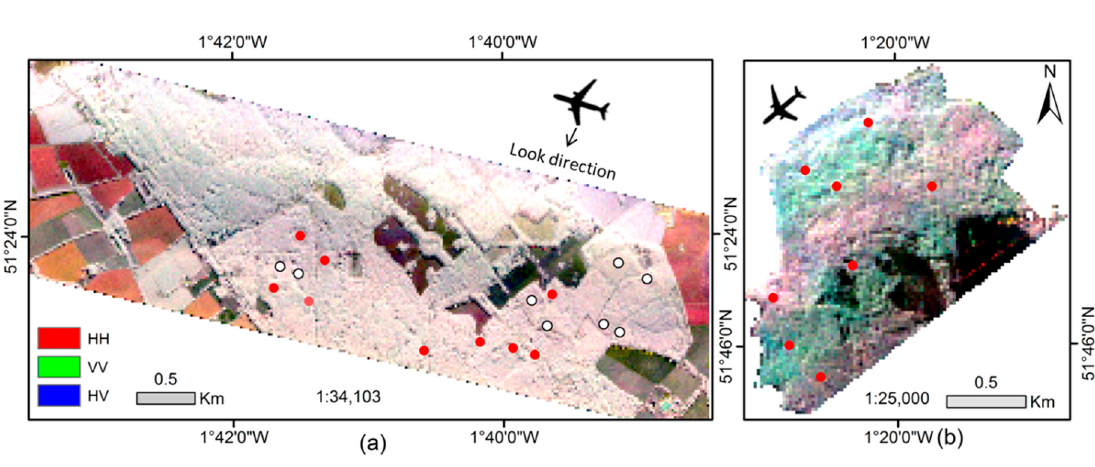
Figure 1. Re-sampled finer resolution (25 m) S-band data acquired over ( a ) Savernake and ( b ) Wytham in June 2014 (False colour composite: red: HH, green: VV, blue: HV) with sampled broadleaved stand plots (red dot) and needleleaved stand plots (white with black border dot in Savernake).